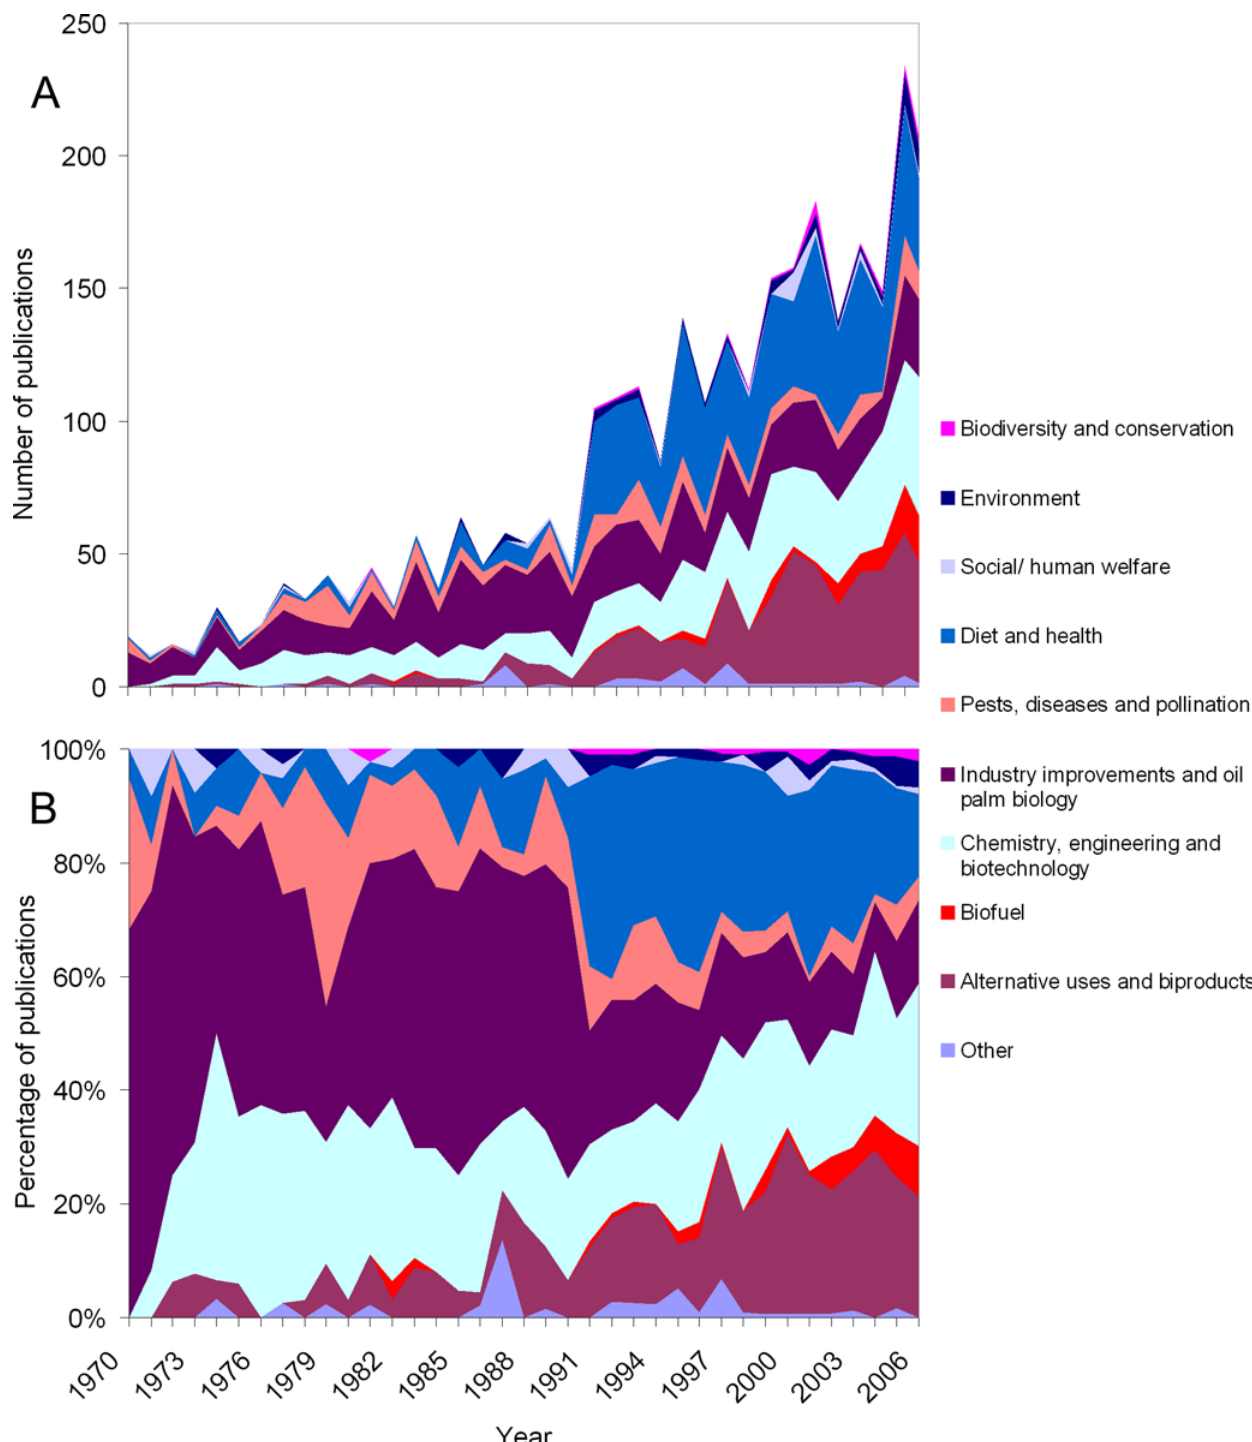
Figure 4. Changes in the focus of research on oil palm between 1970 and 2006 [ 7 ] . Results are plotted as (A) total number of publications and (B) percentage of